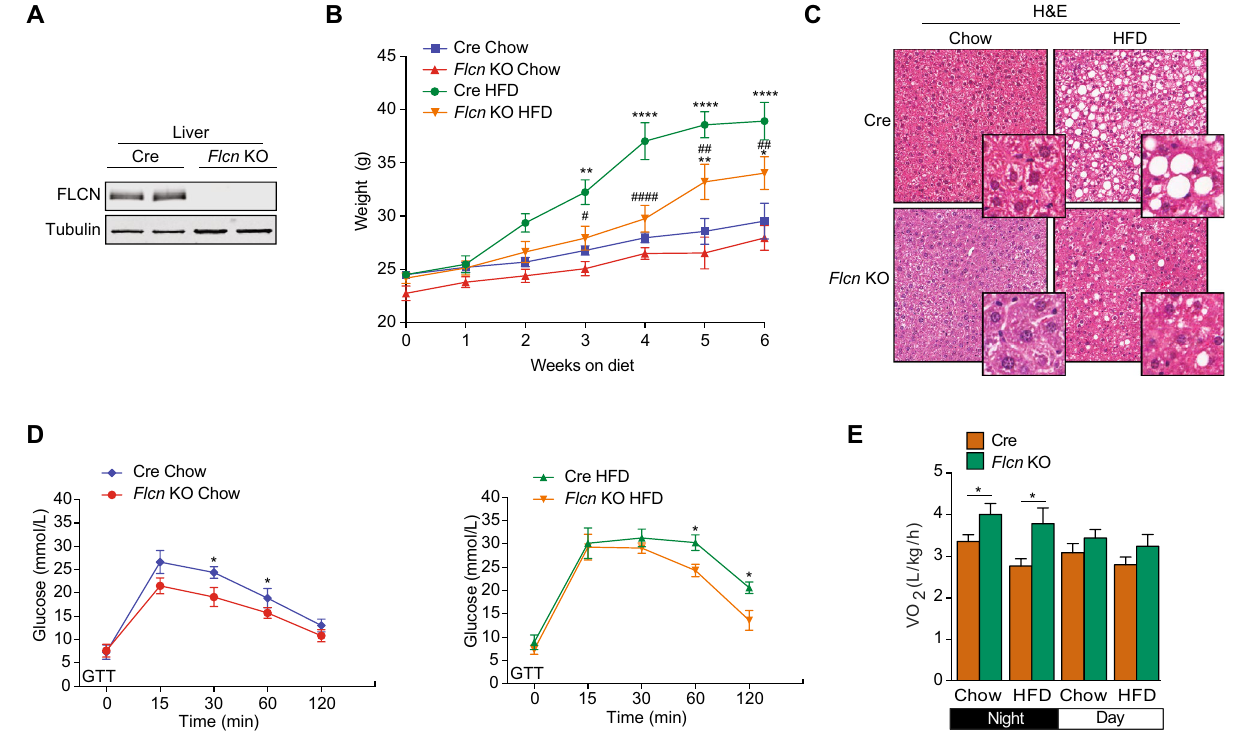
Figure 1. Hepatic loss of Flcn protects against high fat diet stimulated NAFLD. ( A ) Western blot detection of hepatic FLCN protein levels from 3-month-old mice fed standard chow. Full-length blots are presented in Supplementary Fig. 5. ( B ) Mouse body weight when fed either on chow or high fat diet (HFD) over a period of 6 weeks (mean ± SEM, two-way ANOVA, *P < 0.05; **P < 0.01; ****P < 0.0001 compared to Cre-chow, # P < 0.05; ## P < 0.01; #### P < 0.0001 compared to Cre-HFD; n = 6 mice per condition). ( C ) H&E stainings in liver sections of mice fed either chow or high-fat diet (HFD) over a period of 6 weeks. Images are representative of 6 mice per condition. ( D ) Blood glucose during a GTT in chow or HFD-fed mice following a 16-h fast and intraperitoneal glucose administration of 2 g per kg of body weight (mean ± SEM, two-way ANOVA, *P < 0.05; ***P < 0.001; n = 6 mice per condition). ( E ) Quantification of metabolic cage analysis of mice fed chow or a HFD for 2 months. Circadian VO 2 consumption levels during a 12 h light: 12 h dark cycle (mean ± SEM, two-way ANOVA, **P < 0.01; ****P < 0.0001; n = 6 mice per